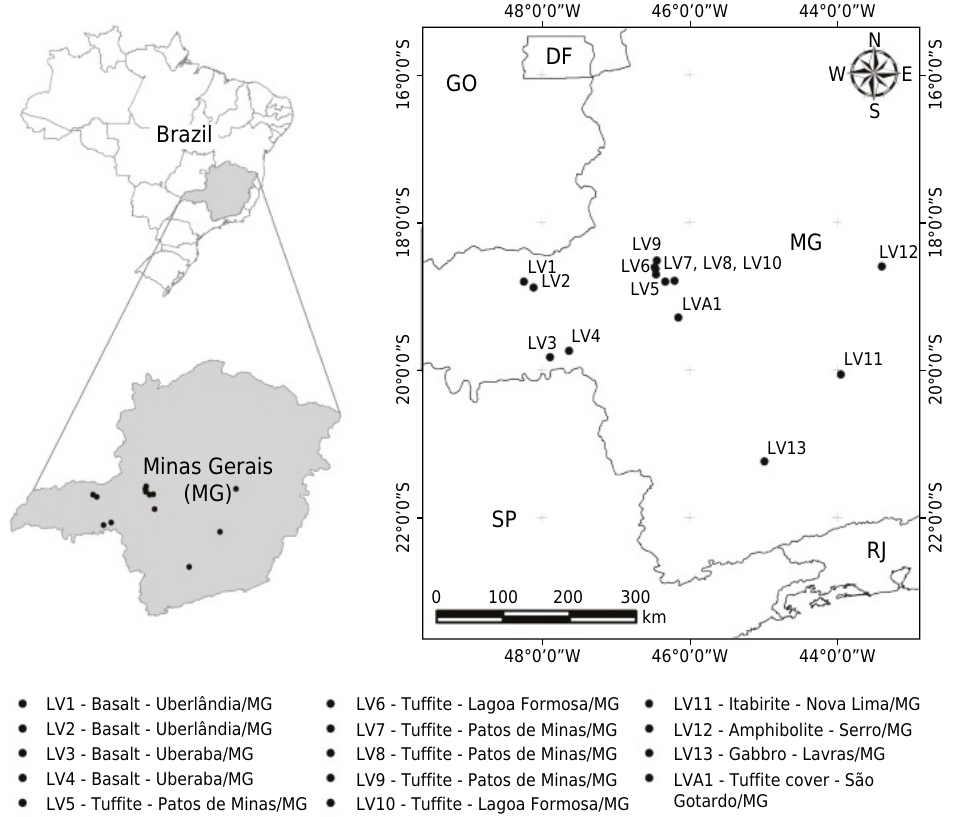
Figure 1. Localization of the soils with their respective parent